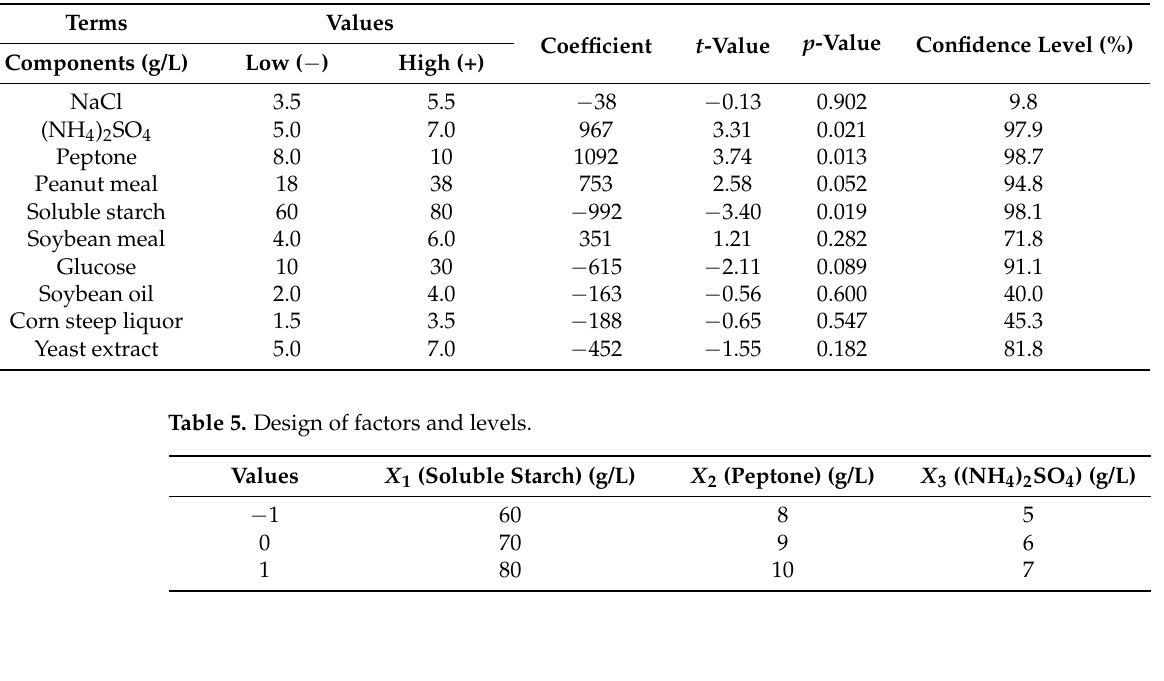
Table 4. Plackett − Burman regression analysis.